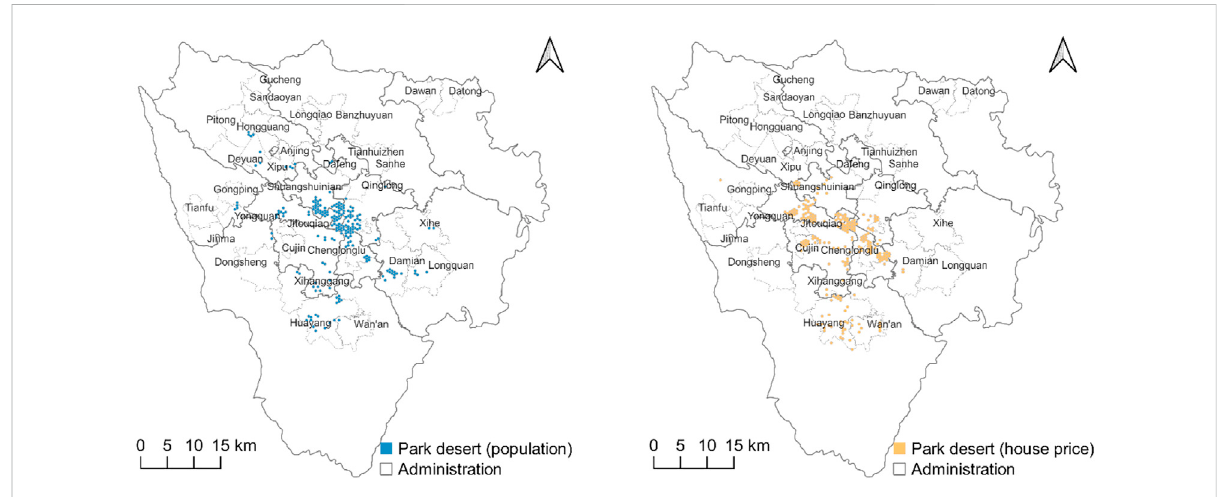
FIGURE 12 Park deserts determined by house price and population in